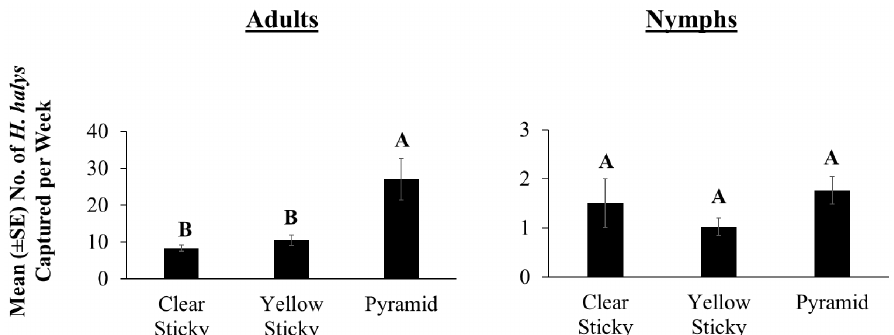
Figure 3. Comparison of H. halys adult and nymphal captures among three trap designs baited with Trécé low loading lures. Captures in these traps were compared across three sites in West Virginia from 26 June to 3 October 2016. Bars with shared letters are not significantly different from each other at α = 0.05 ( χ 2 mean contrast with Bonferroni correction).